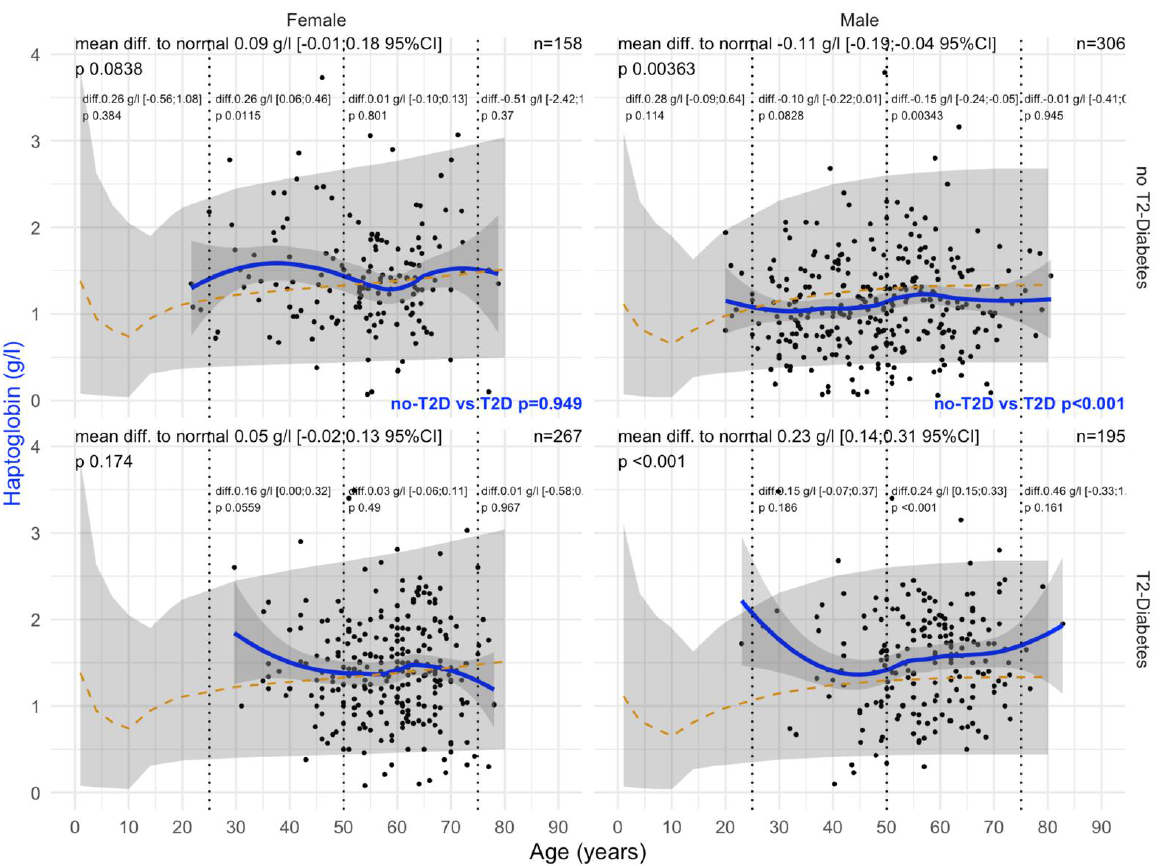
Figure 6. Haptoglobin levels in all “NAFD-Biopsy” patients. Impact of T2DM on Hapto concentration in all NAFD-biopsied patients (n = 926). Normal serum means values according to age and sex (dashed – orange lines), with 95% confidence intervals (light-gray ribbon). Three vertical – dotted lines mark the four age groups (before 25, between 25 and 50, between 50 and 75, and above 75 years old). Each point is a patient ’ s protein value. The green curve is a Loess regression of the median of Hapto values, along with its 95% confidence interval (darker gray). For each age group, the mean difference (%95CI) between the patient protein value and the expected normal value (for age and sex) with its significance p -value is displayed at the top of the figure. The significance between the non-T2DM and T2DM patients is displayed in blue between the 2 panels.